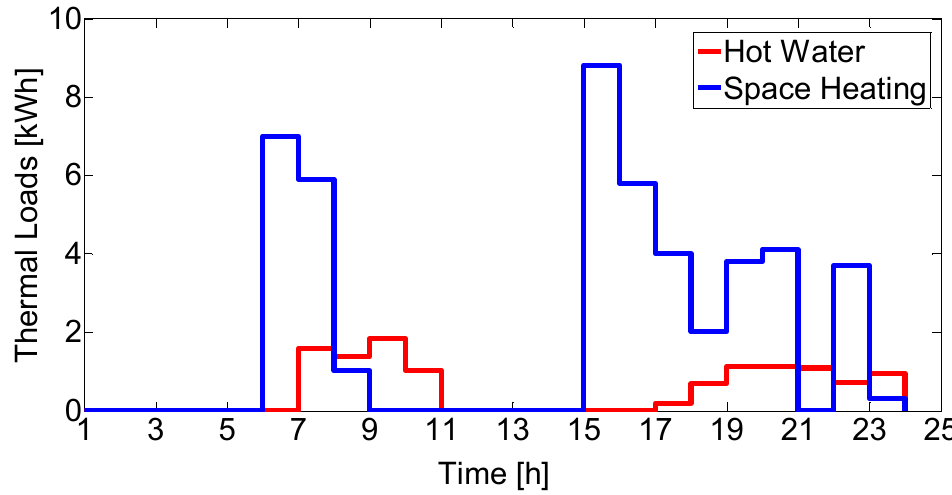
Figure 6. Typical daily thermal loads (winter). The demand for space heating changes by following the degree-hours during the year.